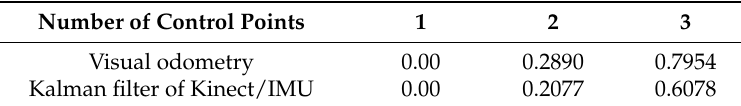
Table 3. Kalman filter error analysis (in